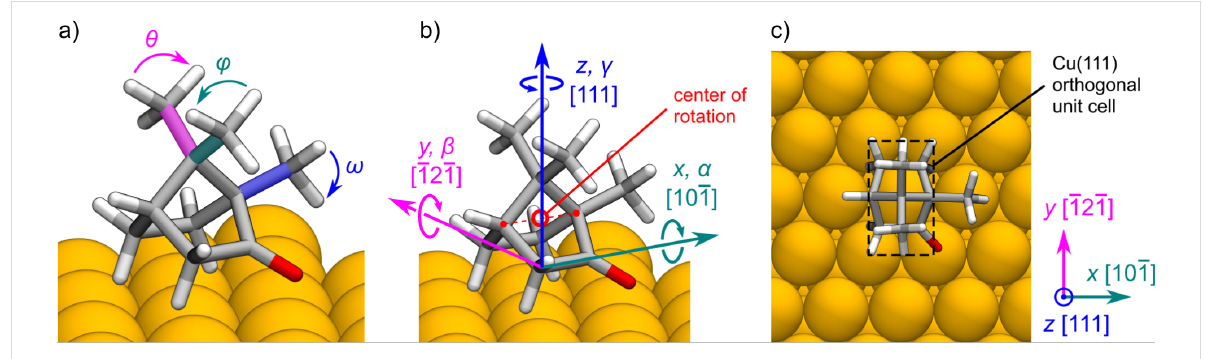
Figure 3: Degrees of freedom for the minimum energy search. (a) Three methyl group rotation angles θ , φ and ω of camphor in the 3D conformer search with BOSS. (b) Three translational directions ( x , y , z ) and three rotation angles ( α , β , γ ) of camphor in the 6D search for stable adsorbate structures. The center of rotation is the middle point between the two carbon atoms, highlighted in red. (c) Orthogonal unit cell of Cu(111), which is the search range in x and y